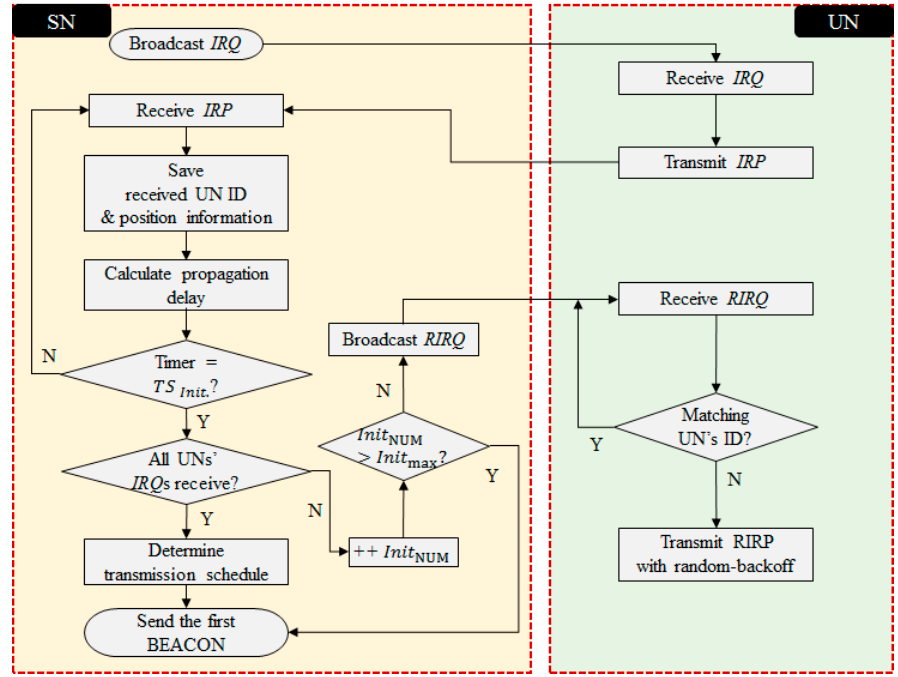
Figure 2. Flow chart for the initialization phase of the APD-TDMA.